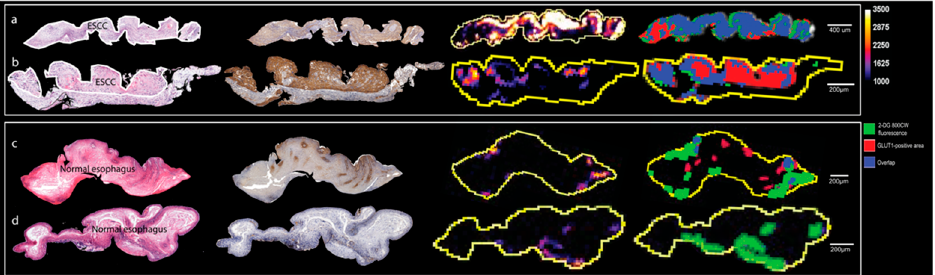
Figure 5. The merge percentage of 2-DG 800CW fluorescence signal in GLUT1 positive area. Each part ( a – d ) shows serial slices of one tissue block. The first column shows the H&E images, with cancer tissue delineated with white lines; the second column shows the anti-GLUT1 IHC results, with positive area stained in brown color; the third column shows the fluorescent images of 2-DG 800CW with a calibration bar of 1000 to 3500; the fourth column shows the merge of 2-DG 800CW fluorescent signal with GLUT1 positive area with a calibration bar of 1000 to 3500. Part ( a ) and ( b ) are ESCC tissue slices; ( c ) and ( d ) are normal esophagus tissue slices.